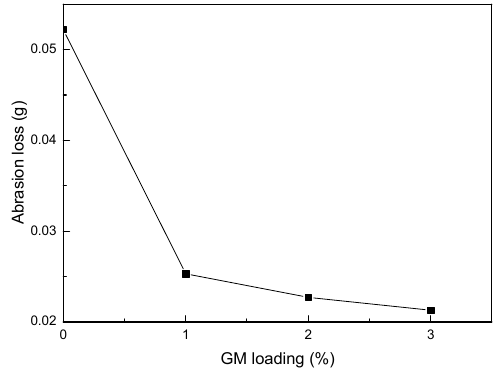
Figure 7. Abrasion resistance of coatings as a function of GM loading.